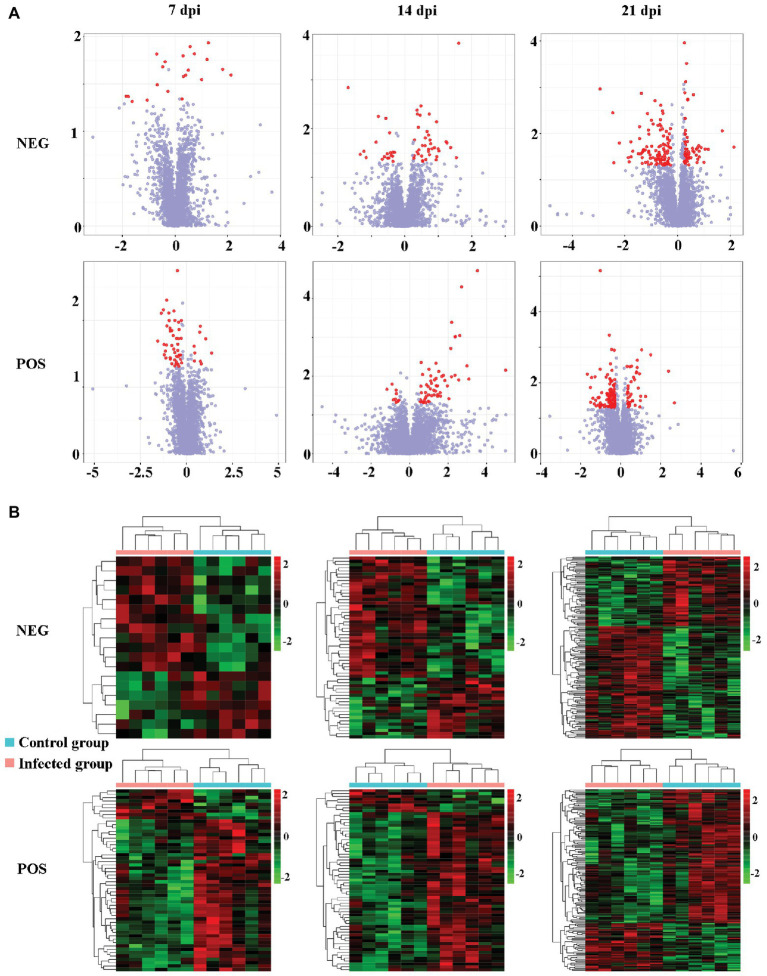
The intensity patterns and hierarchical cluster analysis of the differentially abundant metabolites between infected and non-infected mice in the positive and negative ion modes. (A) Volcano plots showing significantly differentially abundant ions denoted as red dots. The y-axis shows statistical significance values −log10(p) for the abundance of metabolite ions, and the x-axis shows the magnitude of the log2 fold change (log2FC) of metabolite ions between infected and non-infected samples. (B) Heat-map plots of the intensity of the differentially abundant metabolite ions showing significantly different metabolic profiles between infected and non-infected (control) cerebellum samples. Each row represents data for a specific metabolite, and each column represents a mouse (T. gondii-infected or healthy control). Different colors correspond to the different intensity levels of metabolites. Red and green colors represent increased and decreased levels of metabolites, respectively.